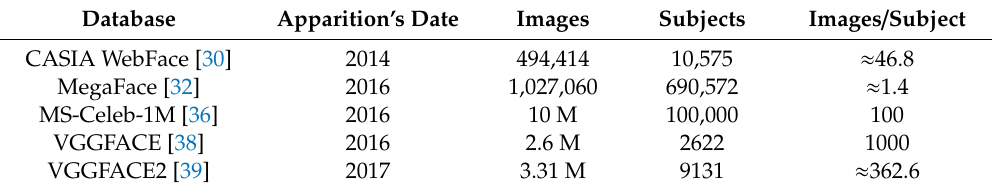
Table 2. Comparative summary of the most well-known / recent 2D face recognition datasets used only for training deep face recognition